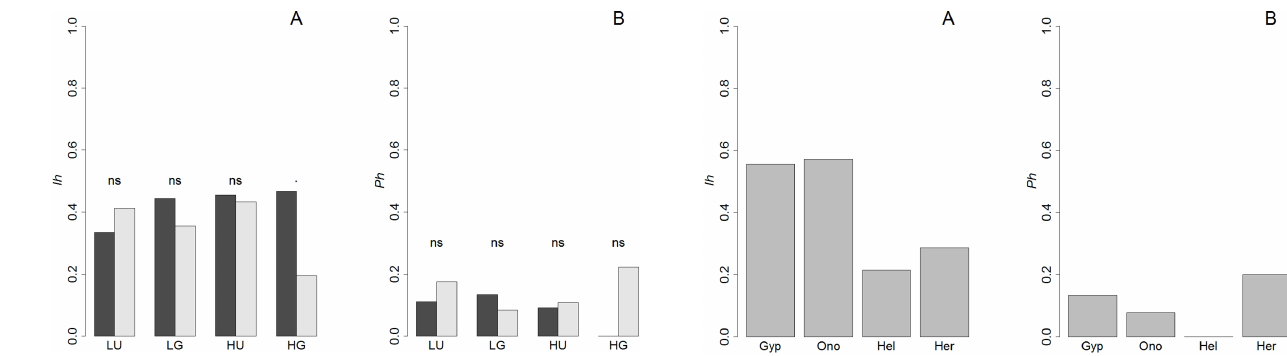
Figure 4. Importance of each gypsophyte species in the study area of the middle Ebro Valley, Spain. Gypso : G. struthium subsp. his- panica ; Ono: O. tridentata ; Hel: Hel. Squamatum ; Her: Her. fru- ticosa . (A) Proportion of times that each gypsophyte appeared in high intrapartition degree group (Ih) in the study area. (B) Propor- tion of times that each gypsophyte appeared in high participation group (Ph) in the study area. There were no significant differences between